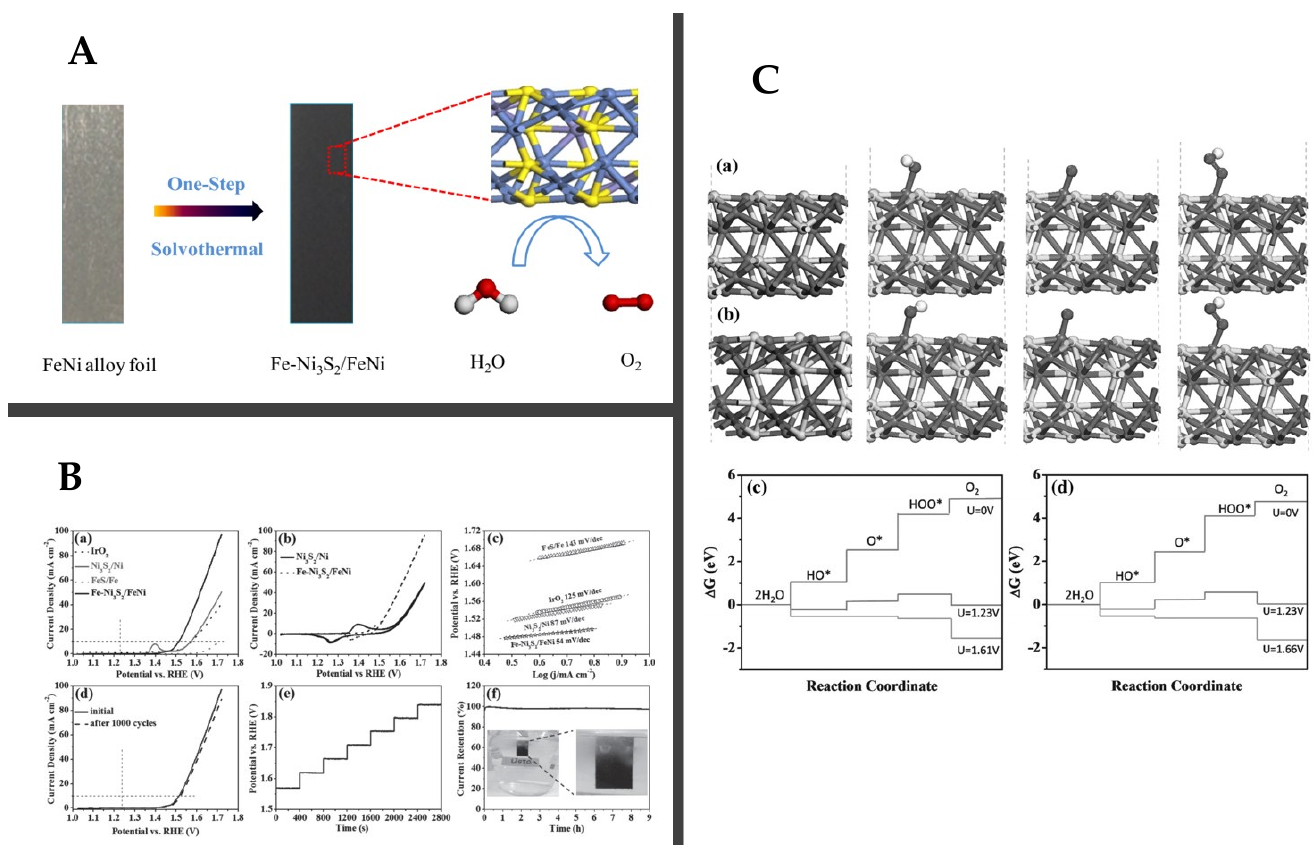
Figure 6. ( A ) Schematic illustration for preparation method, ( B ) Prepared electrocatalyst Fe − Ni 3 S 2 /FeNi with efficient OER performance ( a , b ), Tafel slope ( c ), stability test ( d ), Time-dependent current density curves ( e ) and the corresponding photographs of water oxidation device ( f ), ( C ) Density Functional Theory (DFT) calculations in Scheme ( a , b , c , d ) Reprint from [175]. Copyright (2021), with permission from Wiley.